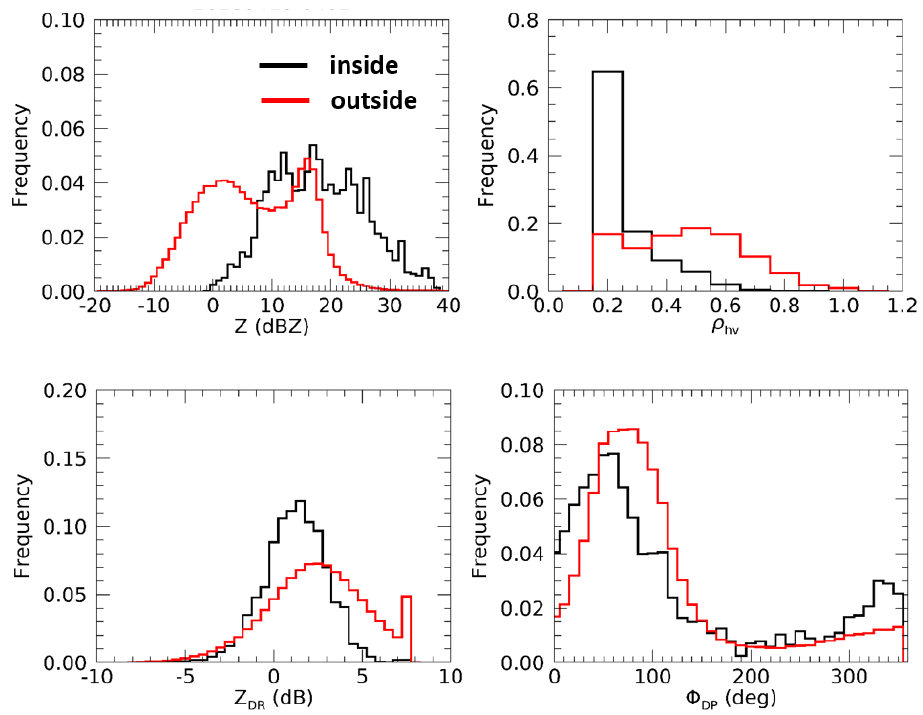
Figure 11. Histograms of the polarimetric variables taken from 0.5° elevation scan at 04:02 UTC.